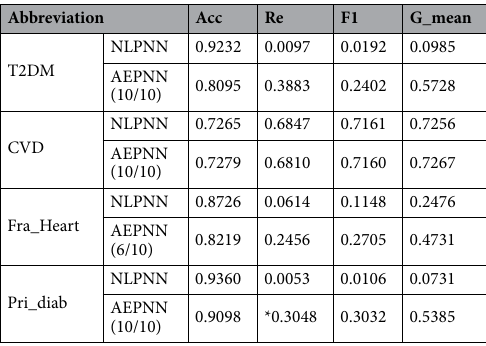
Table 5. Performance of two proposed algorithms on four datasets with class